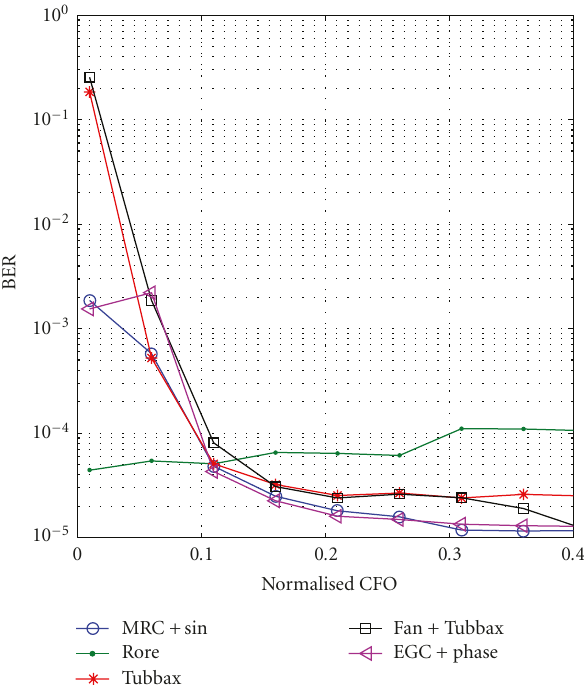
Figure 9: BER at di ff erent SNRs in uncoded system with random CFO in [0,1] and random I/Q mismatch which is uniformly distributed in [0,1]dB for gain mismatch and [0,4 ◦ ] for phase